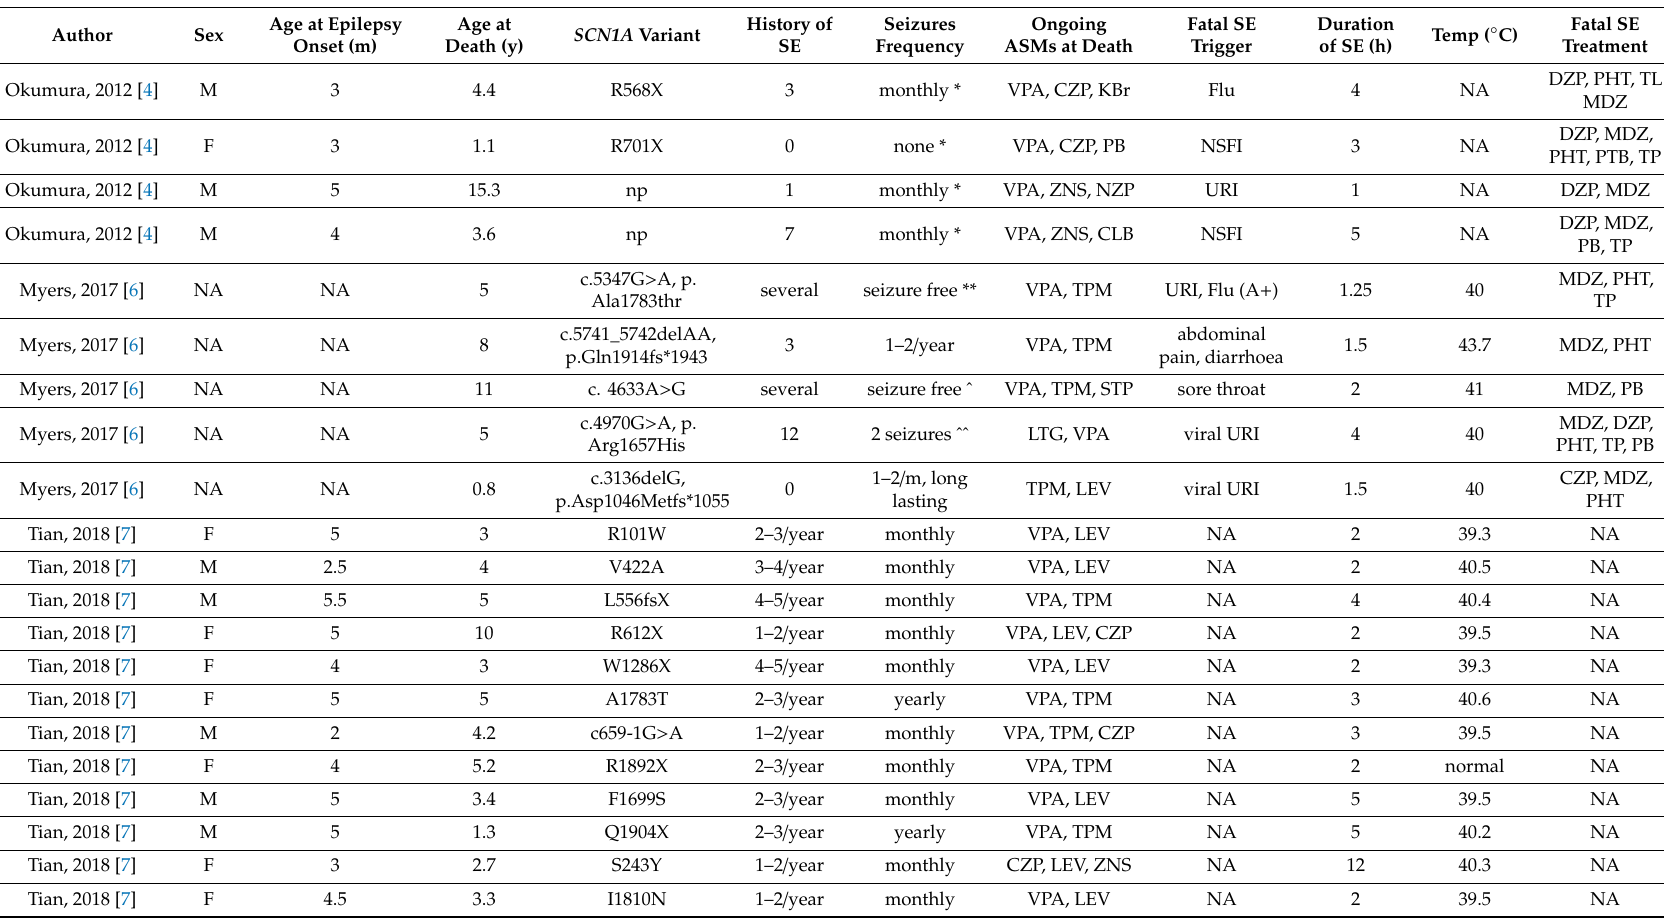
Table 2. Published cases of death of patients with Dravet syndrome presenting acute encephalopathy during status